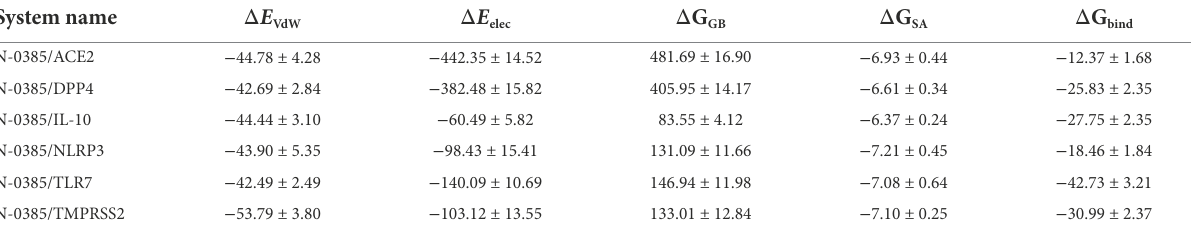
TABLE 2 Binding free energies and energy components predicted by MM/GBSA